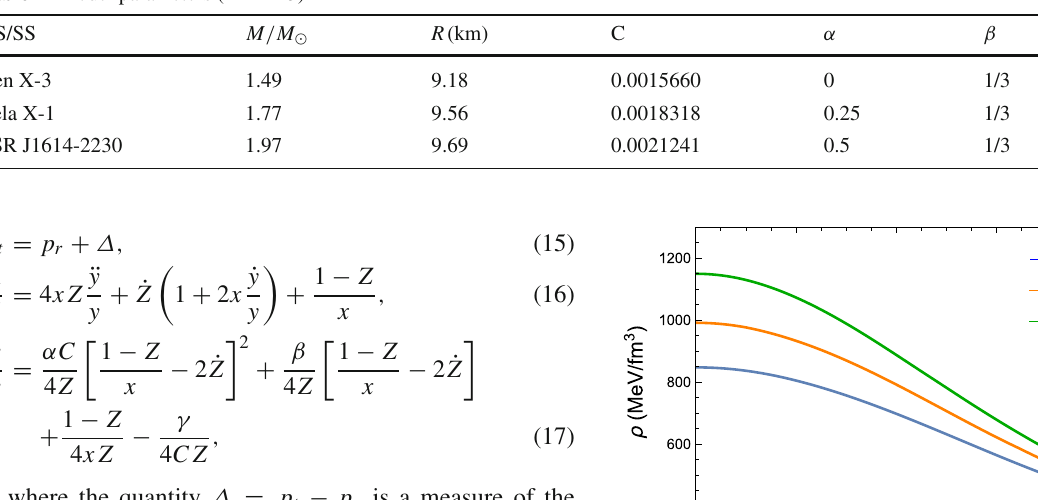
Table 1 Model parameters ( K = − 5)